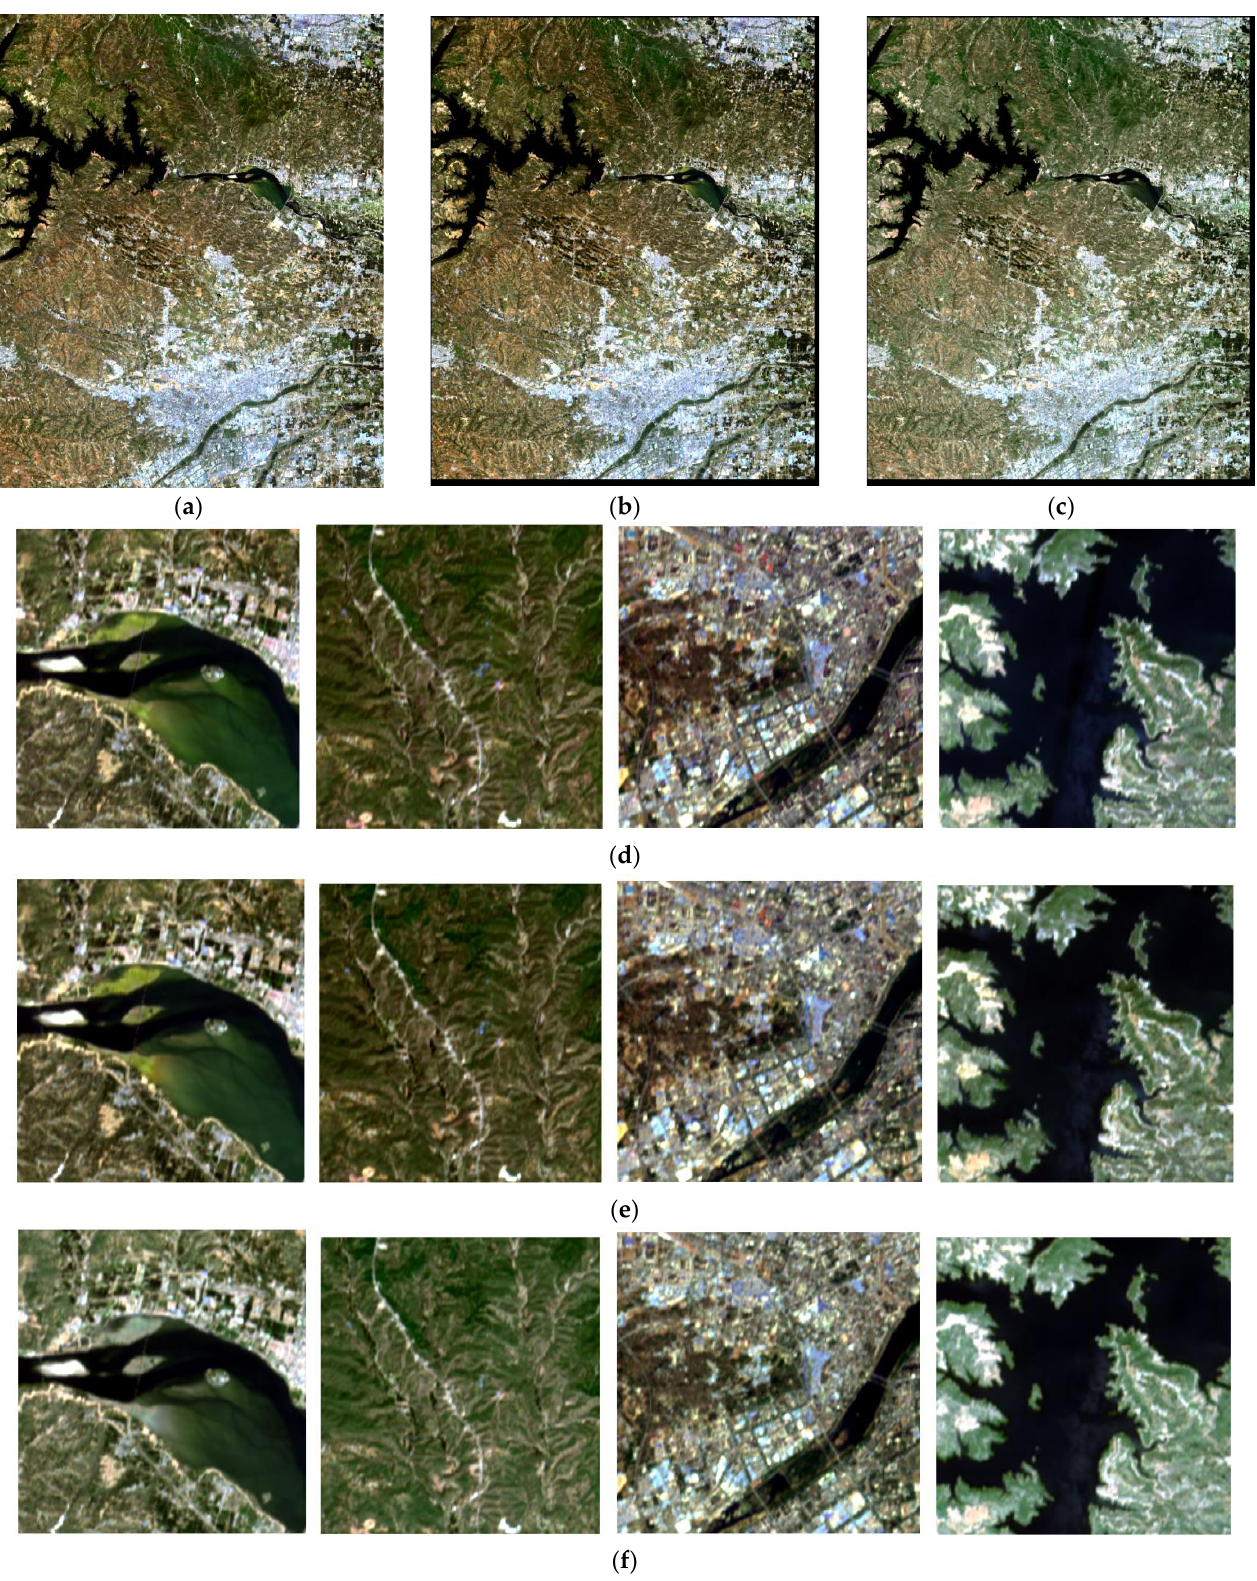
Figure 5. RGB composite of fusion result comparison between SRE-ResNet and ResNet for Dataset II. ( a – c ) are the whole scene of ground truth, prediction of SRE-ResNet and ResNet. ( d – f ) are the detailed scene of ground truth, prediction of SRE-ResNet and ResNet.